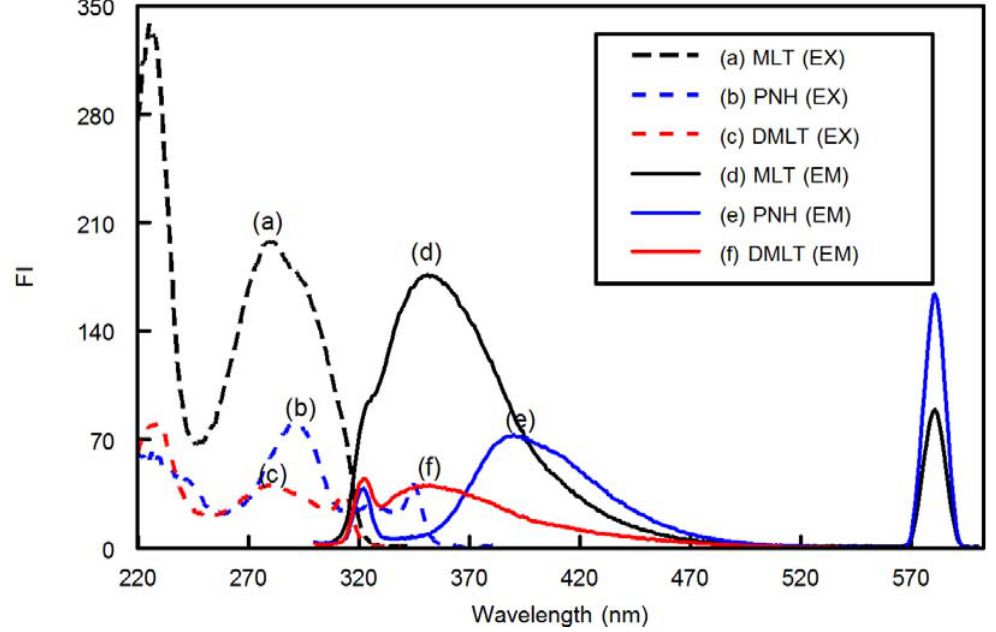
Figure 2. Excitation (dashed lines) and emission (solid lines) for MLT (a and d), PNH (b and e) and DMLT (c and f). Concentrations of all components were 100 ng mL − 1 in phosphate buffer solution (pH 3, 0.1 M).